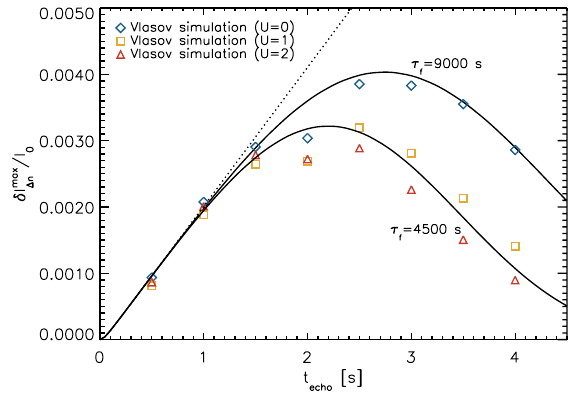
FIG. 7. (Color) Comparison of the maximum echo amplitude obtained from the simulation ( U (cid:2) 0 versus the echo time t echo blue diamonds, U (cid:2) 1 orange squares, U (cid:2) 2 red triangles), from the ballistic echo theory for zero (dotted line), finite D (solid line), and from the amplitude fit to the collective echo theory (dashed